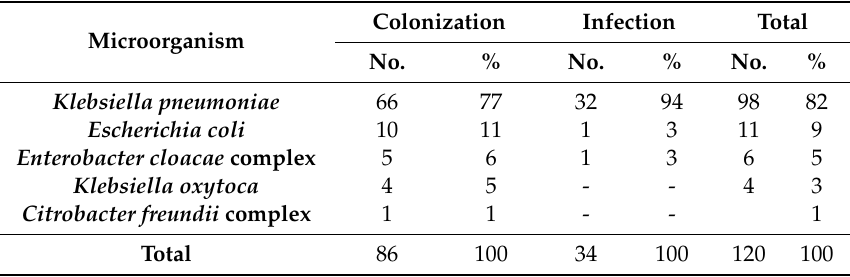
Table 1. Enterobacterales species identified as carbapenemase